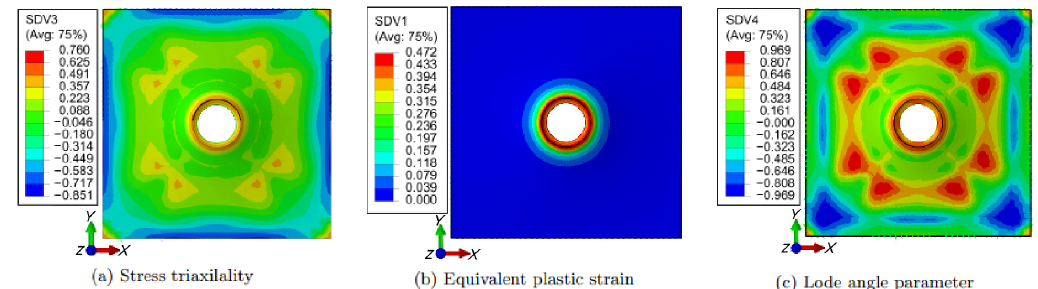
Fig. 11 FE simulation of hole expansion: distributions of (a) stress triaxiality, (b) equivalent plastic strain, and (c) Lode angle parameter.